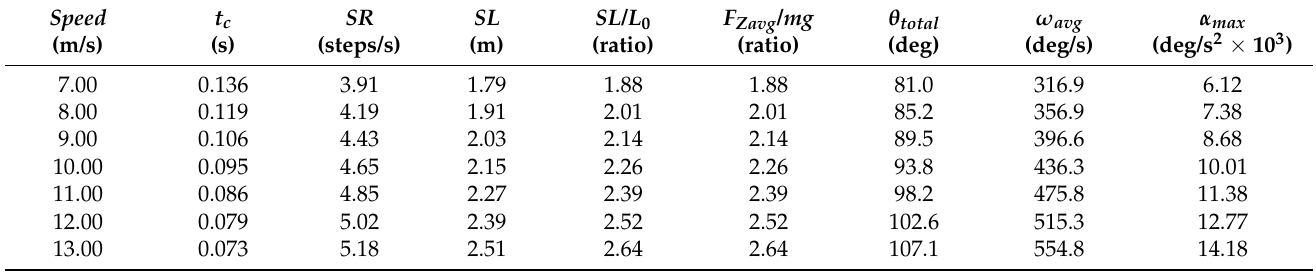
Table 2. Calculated values across a range of speeds for a hypothetical athlete with L 0 = 0.95 m.